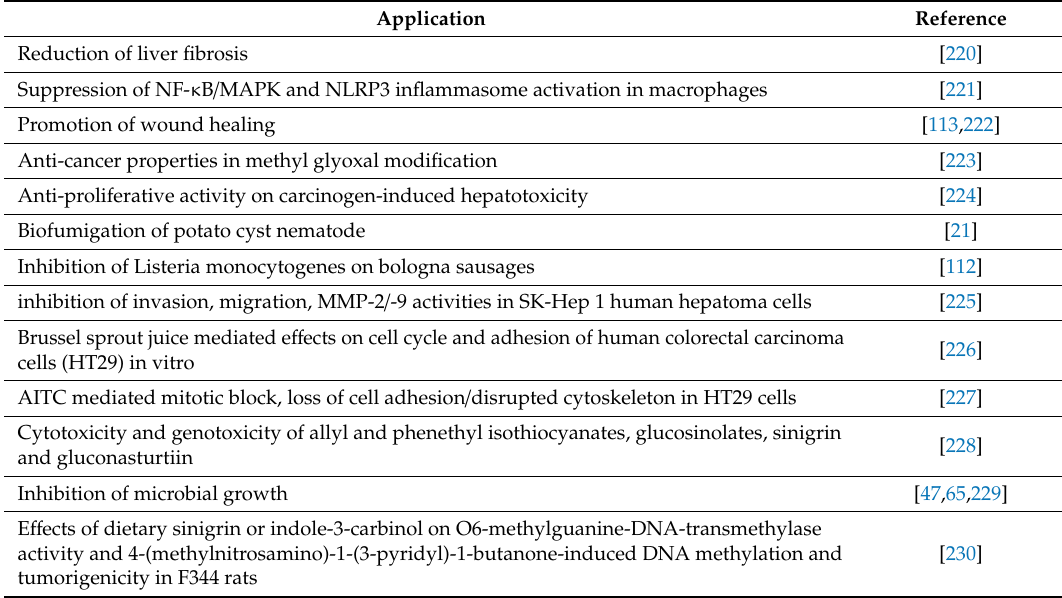
Table 7. The Varied Applications of Sinigrin in Biomedicine.